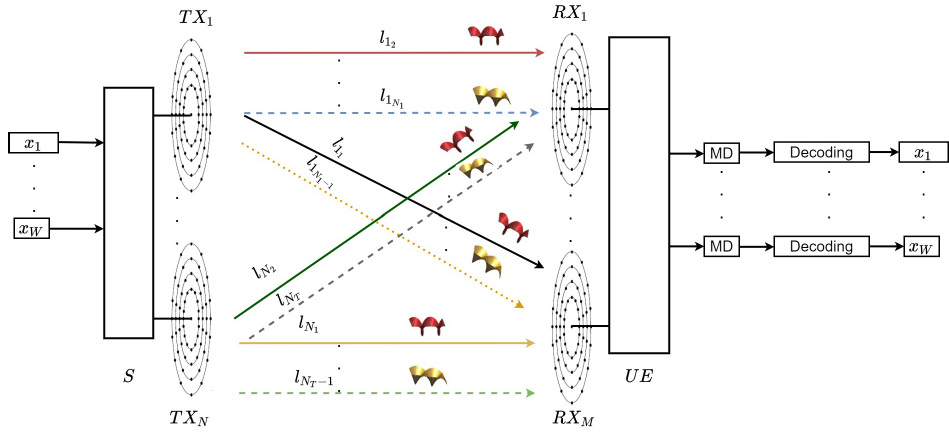
Figure 1. System Model and system architecture of DL